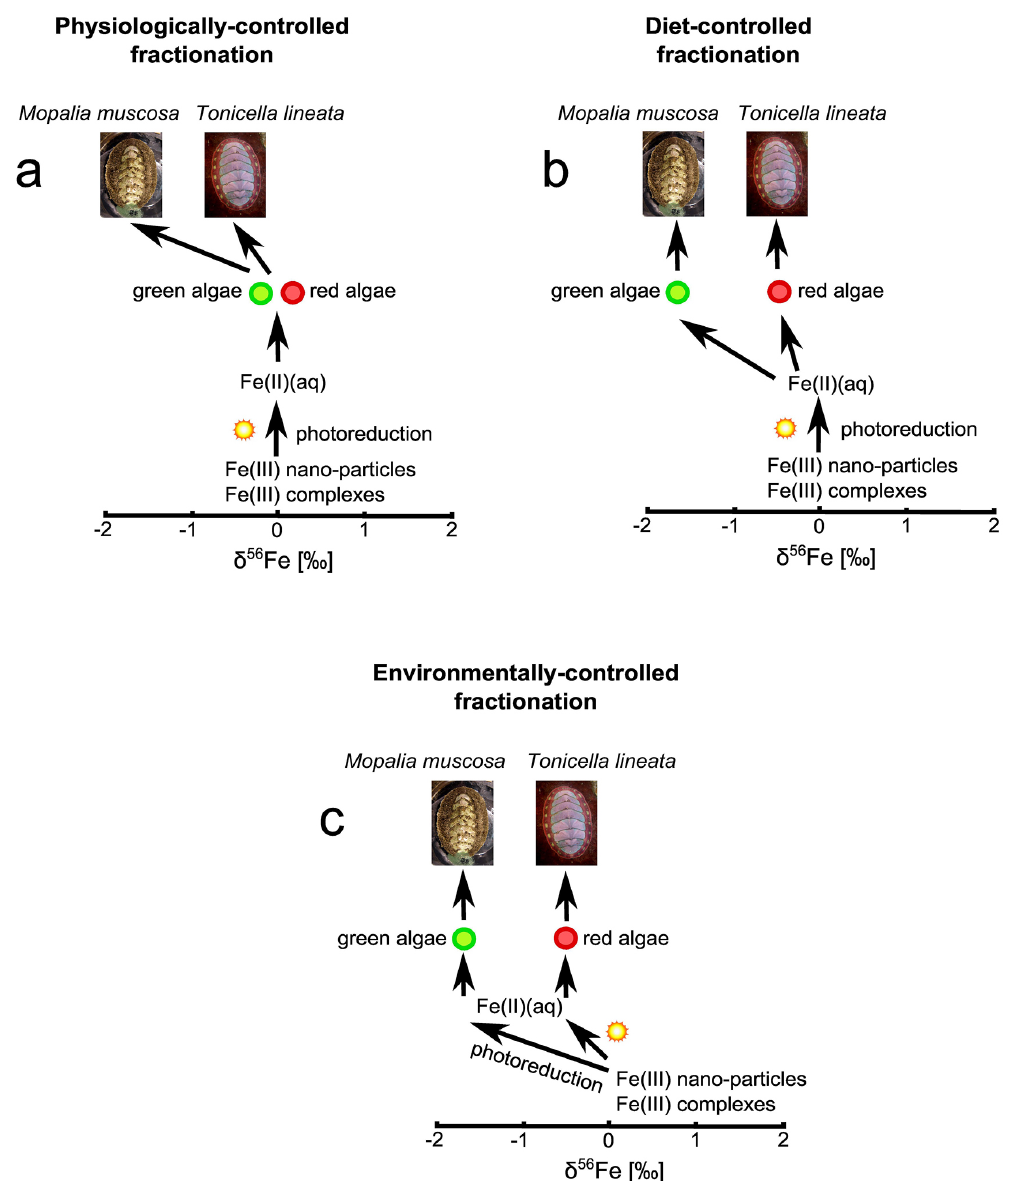
Figure 3. Schematic pathways for isotope fractionation of iron present in seawater and different chiton species. Fractionation could occur during (a) physiologically controlled biomineralization processes within the chitons, (b) fractionation during uptake by algae and subsequent ingestion, and (c) environmentally controlled photoreductive dissolution of Fe complexes and nanoparticles in seawater. The mechanisms are not mutually exclusive and the signatures in the chiton teeth could reflect a combination of different